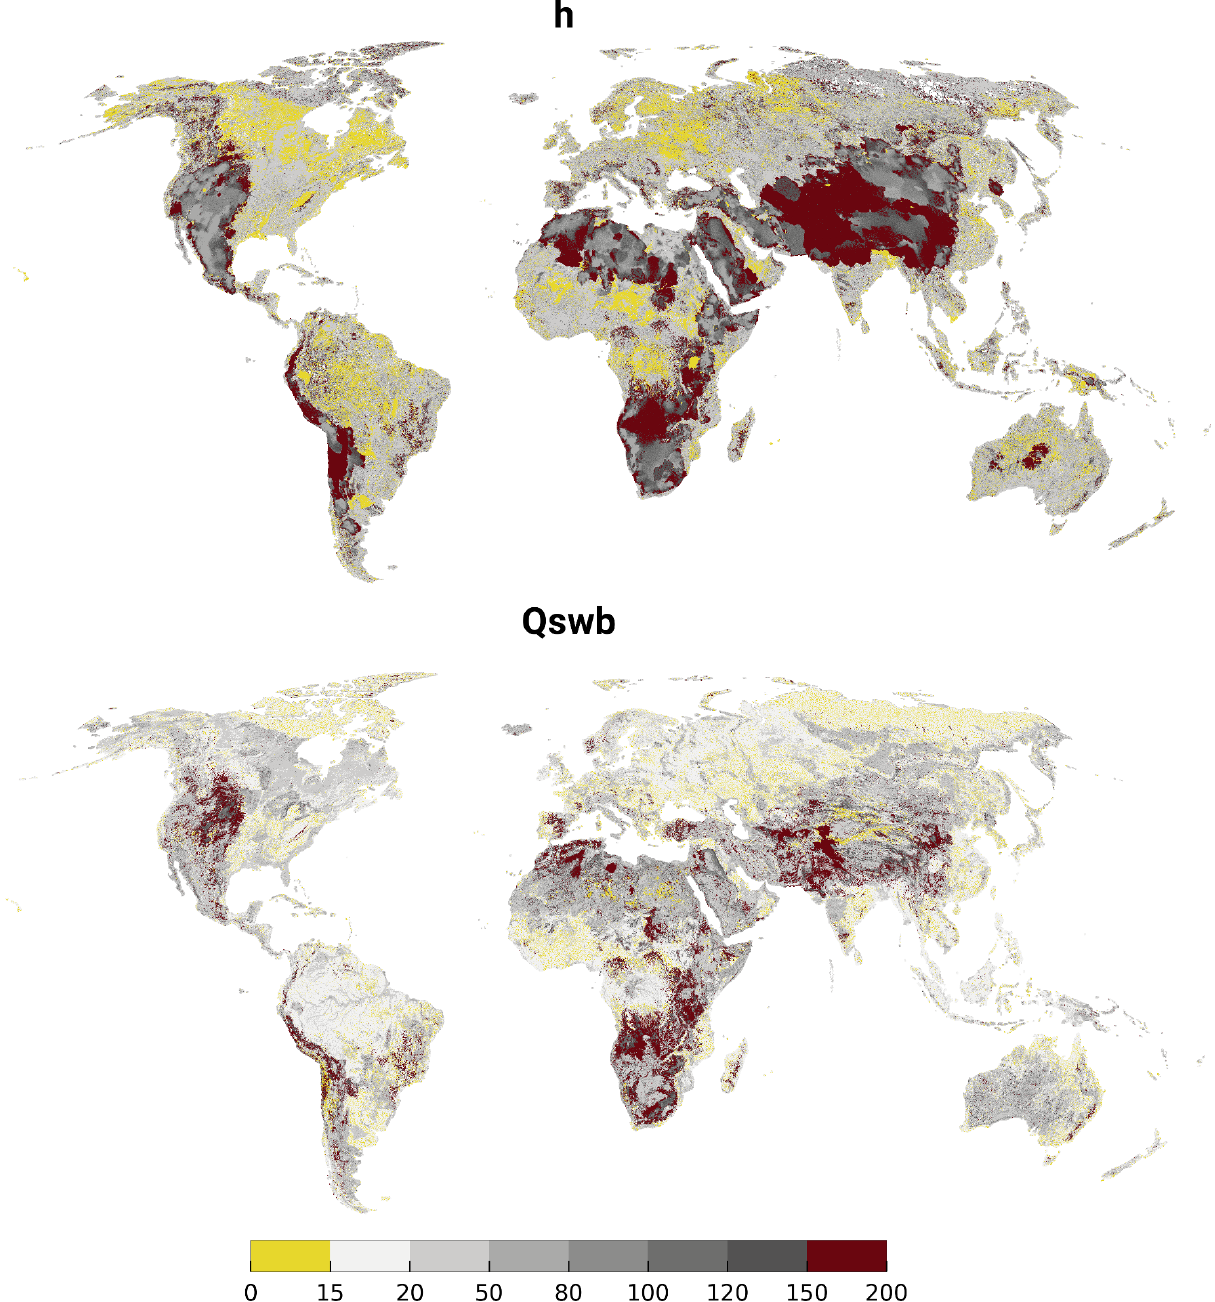
Figure A2. Confidence interval (95) in relation to the µ ∗ for rank 1 of h and Q swb . Yellow regions indicate a sufficient sampling size.